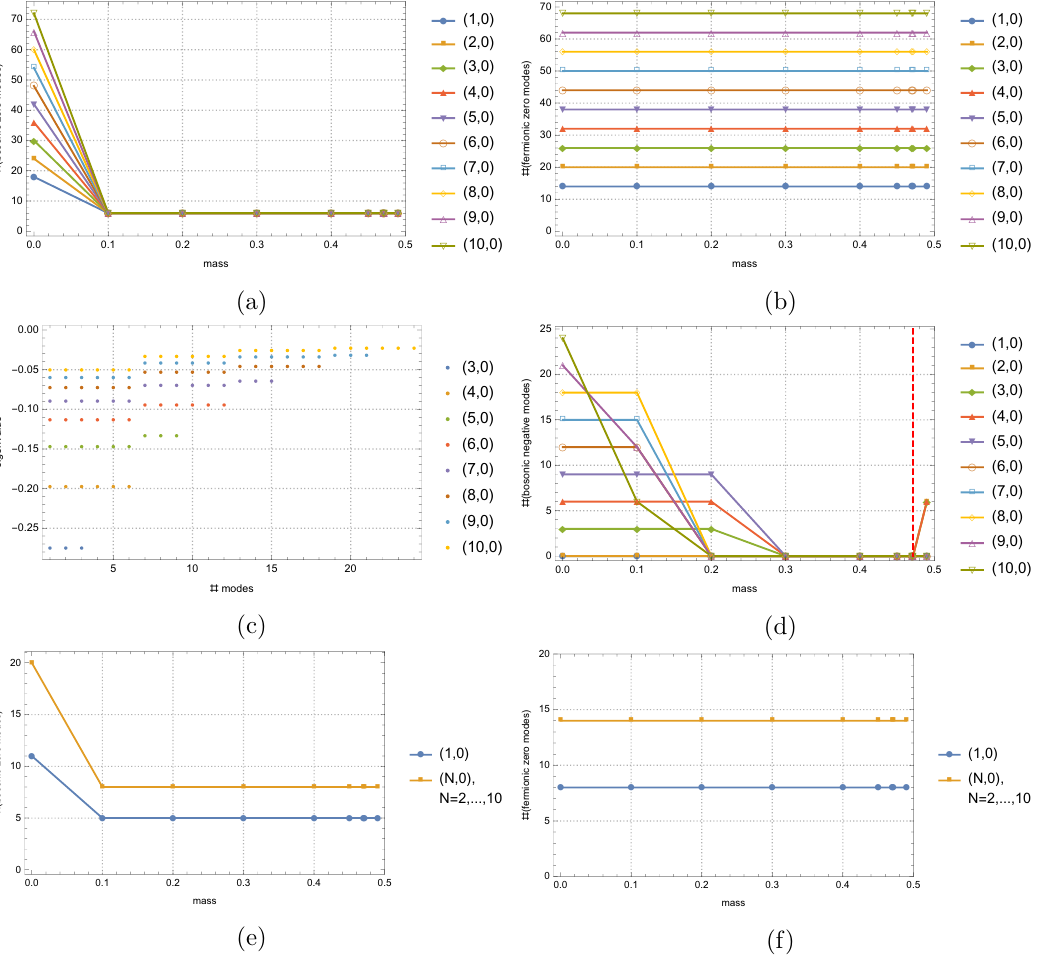
Figure 25. C [( N; 0)] brane with or without maximal Higgs. For pure C [( N; 0)] background, the number of zero modes of O X are shown in (a), whereas the number of zero modes for =D X is shown V in (b). For combined background C [( N; 0)] plus maximal Higgs, the negative modes of O X to O X ) with their corresponding eigenvalue are shown in (c). For this set-up with uniform mass V; (cid:12)x parameter M , we display the number of negative modes of O X + (cid:30) in (d) and zero modes in (e), whereas the zero modes of =D X + (cid:30) are show in (f). The red dashed vertical line in (d) indicates the p critical mass value M (cid:3) = 2 = 3 where the potential vanishes for all these solutions, see (cid:12)gure 24.